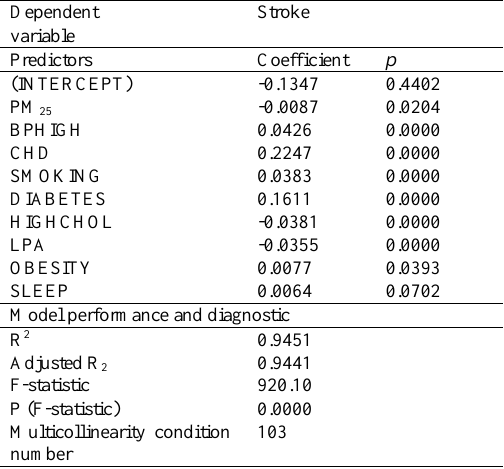
Table 3. Multivariate linear regression